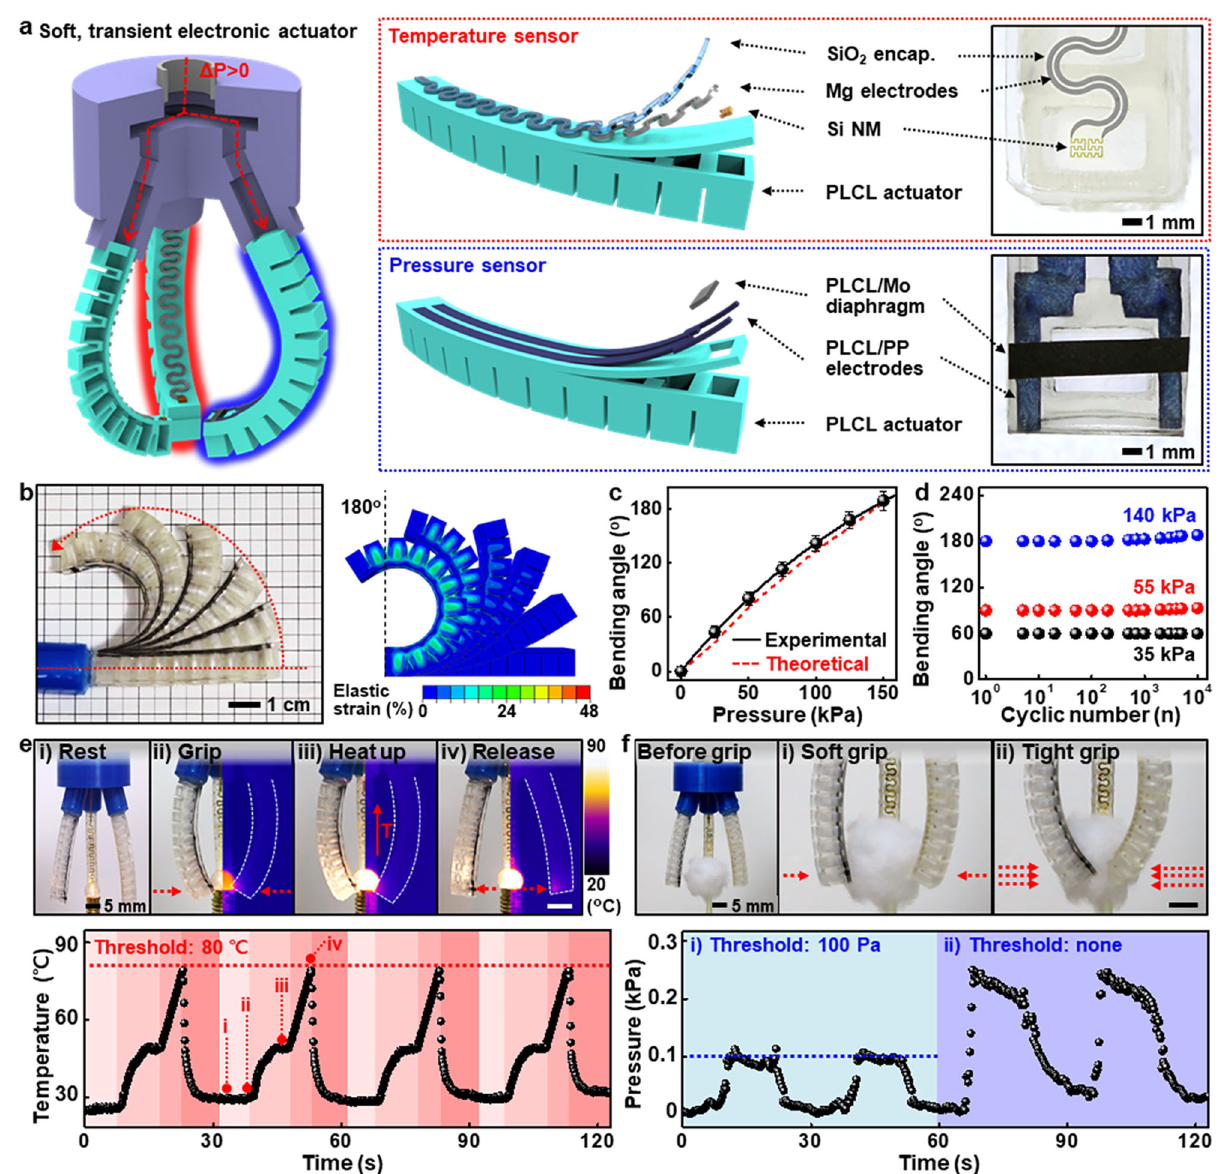
Fig.4 |Smarttransientsoftrobotswithintegratedelectronics.a Descriptionof aPLCL-basedtransientroboticgrippercapableofperceivingenvironmentalfactors such as temperature and pressure via integrated electronic components (left) and schematic exploded (middle) and magni fi ed (right) views of individual sensing elements. b Photograph(left)and fi niteelement simulation result (right)atseveral states of bending actuation of the gripper. When bent to 180°, the gripper experienced only a strain of less than 20%, corresponding to the elastic region of PLCL. c